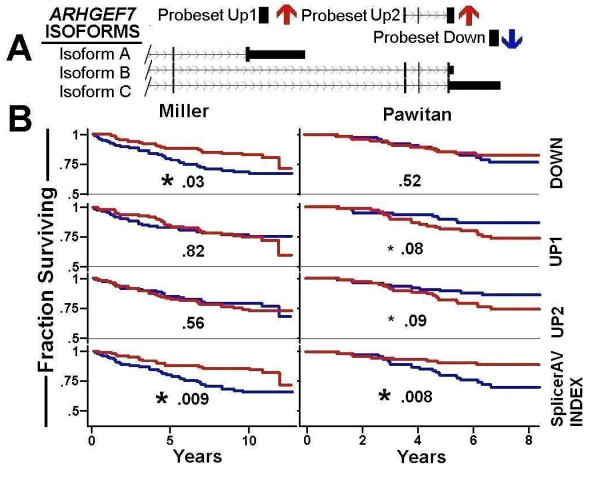
SplicerAV Index of ARHGEF7 is associated with breast cancer survival. Panel A. Schematic representation of ARHGEF7 isoforms A, B and C, with regions interrogated by probesets that increase shown as Probesets Up 1 and 2 (red arrows), and the region which decreases denoted as Probeset Down (blue arrow). Panel B. The fraction of patients surviving in each cohort (vertical axis) is shown over time in years (horizontal axis) as a function of individual probeset expression or SplicerAV index. Survival of patients in the top (red line) and bottom (blue line) 50th percentile are plotted by individual probeset expression (Down, UP1, and UP2) and the SplicerAV index within the Miller (left) and Pawitan (right) cohorts. Results of two-tailed logrank tests of survival are shown, with asterisks indicating significance at the .05 (large asterisk) and .10 (small asterisk) levels.